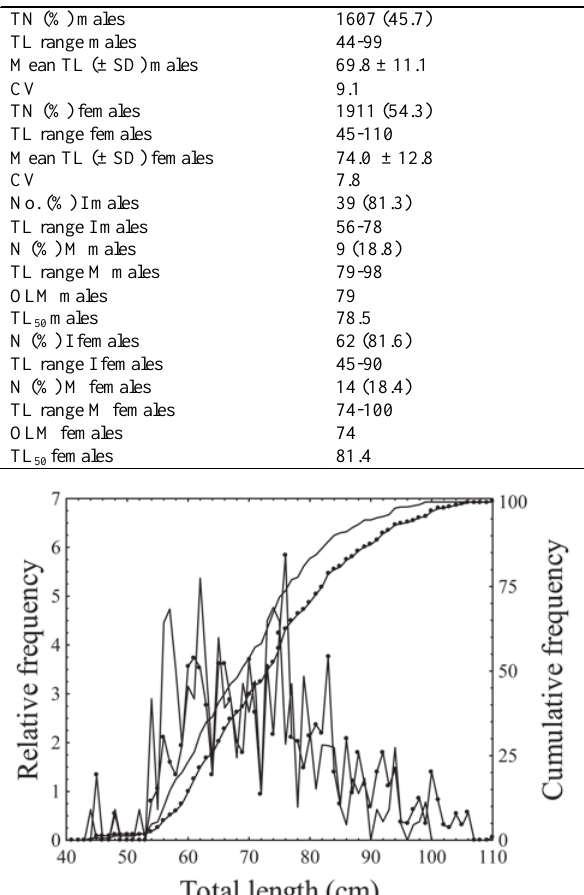
Table 1. Total number (TN) and percentage (%) of specimens of Dipturus chilensis determined along with the standard deviation (SD, in parentheses), total length range (TL range, cm), mean total length (Mean TL, along with the standard deviation), CV (coefficient of variation) and number (N) and percentage (%) of individuals assessed for reproduction analysis by maturity stage (immature=I; mature=M) and sex; total length range (TL range) by sex; observed length-at- maturity (OLM) and size at which 50% of the individuals were sexually mature (T ). L50